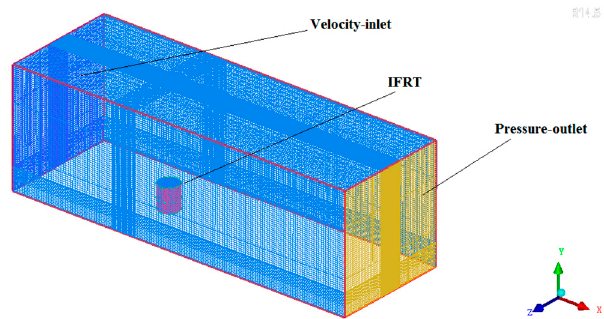
Figure 2. Grid model for oil-vapor diffusion of the Internal floating-roof tank (IFRT).